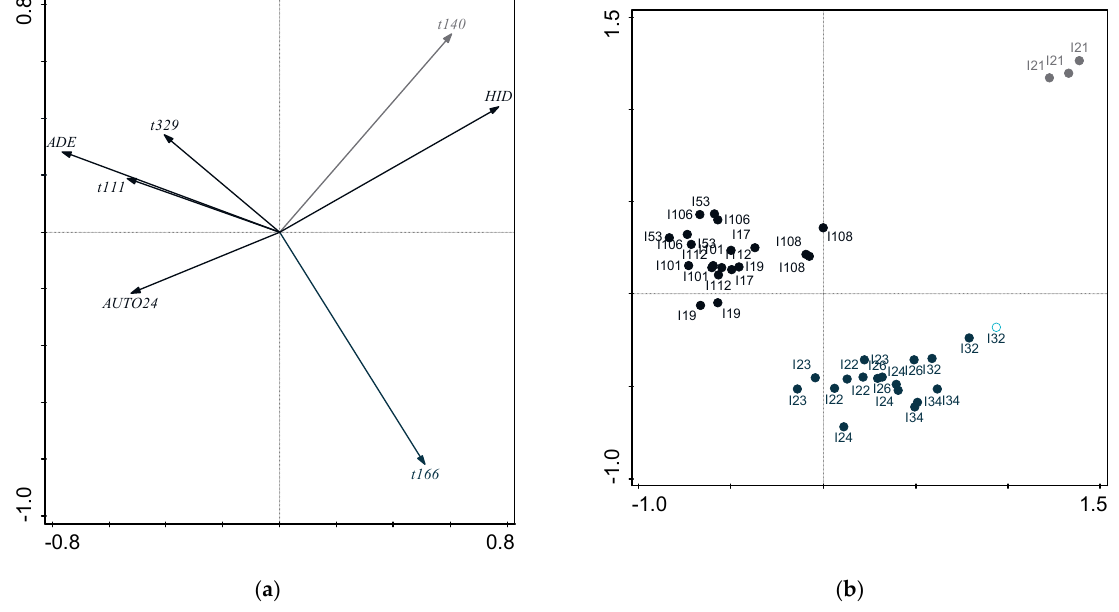
Figure 3. ( a ) Plot of loadings formed by first two principal components from Principal Component Analysis, pertaining to probiotic characteristics associated with gastrointestinal tract and time of processing; and ( b ) plot of scores encompassing strains from Cobrançosa LAB table olives.